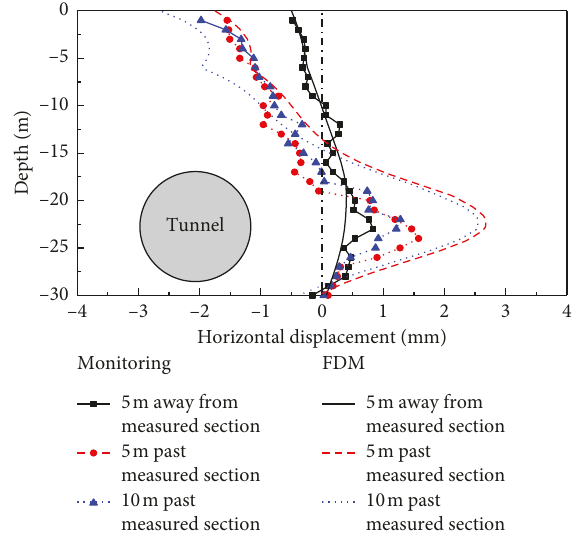
Figure 17: Horizontal displacements along depth.